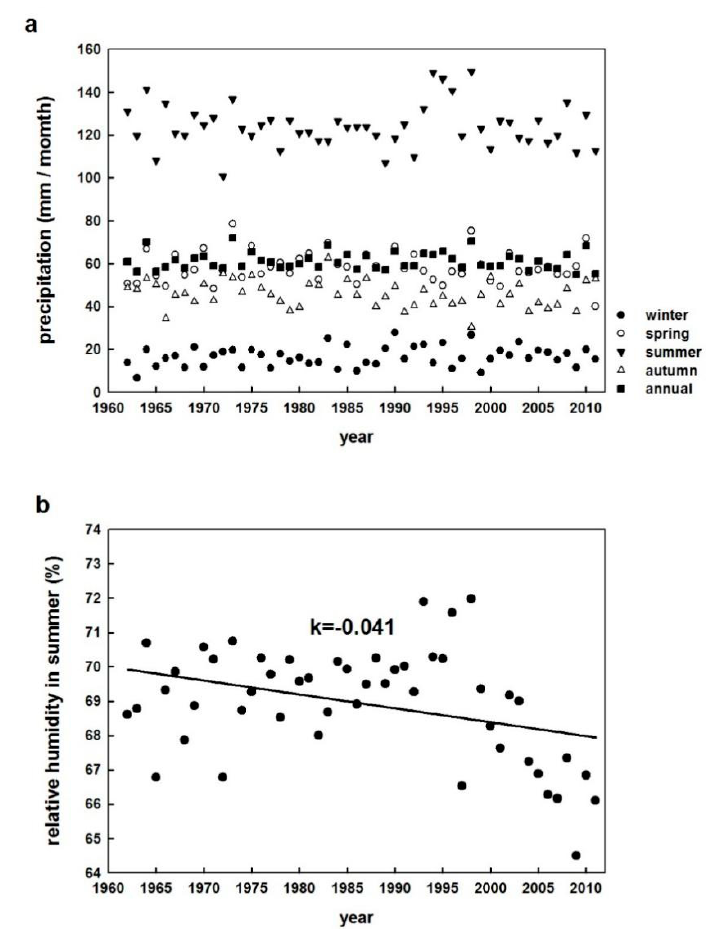
Figure 7. ( a ) Precipitation (p) on annual and seasonal scales in China during 1962–2011. The annual averaged values of 12 monthly accumulated precipitations were used in this graph. Linear trends of precipitation were not significant ( p > 0.05). ( b ) Relative humidity in summer in China during 1962–2011. The seasonal averaged values (summer) of daily mean relative humidity were used in this graph. The solid line represents the linear trend and k represents the rate of change (% / year). r 2 = 0.38, p < 0.05.